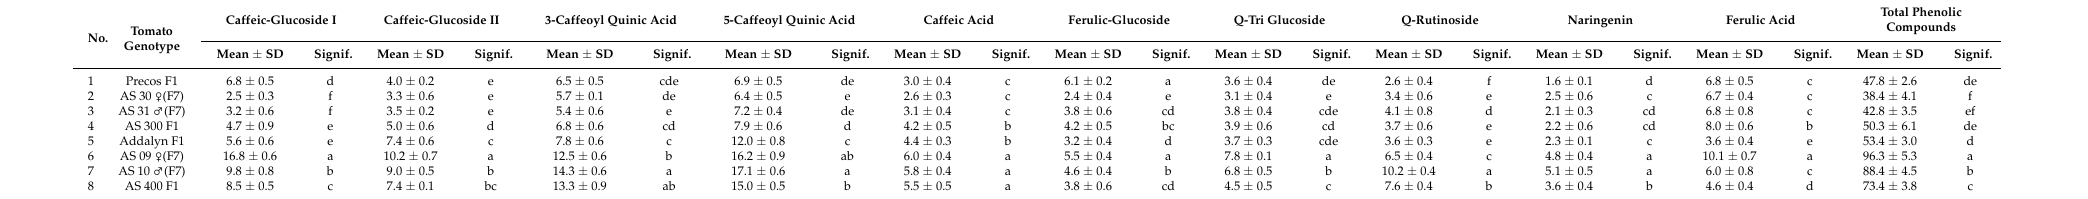
Table 2. Total phenolic compounds content analysed, expressed in µ g/g fresh